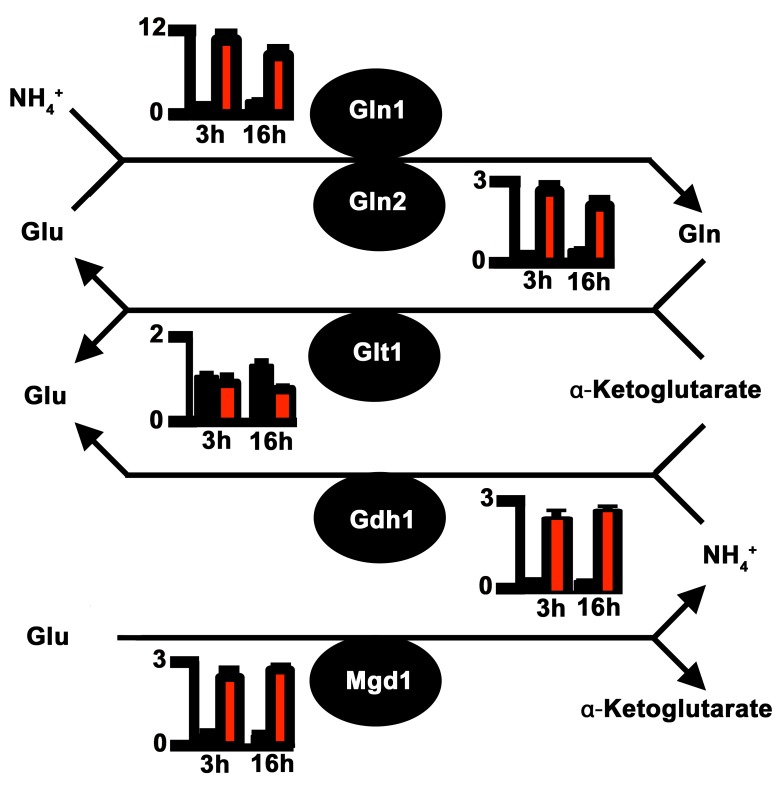
Proposed pathway of nitrogen assimilation and glutaminolysis in M. oryzae based on sequence homology.Nitrogen is assimilated and distributed via glutamine synthetase (Gln1 and Gln2) and glutamate synthase (Glt1) or anabolic NADP-dependent glutamate dehydrogenase (Gdh1) and Gln1-2 [24, 25]. Glutaminolysis [26] involves NAD-dependent glutamate dehydrogenase (Mgd1). Enzymes are depicted as solid circles with the adjacent bar graphs showing the relative expression levels of the encoding genes in WT (black bar) and Δasd4 mutant strains (red bar) following 3 h and 16 h growth in GMM with 10 mM NH4
+ as the sole nitrogen source. Results were normalized against the expression of the β-tubulin gene TUB2. Values are the average of three results from at least two independent biological replicates. Error bars are standard deviation.